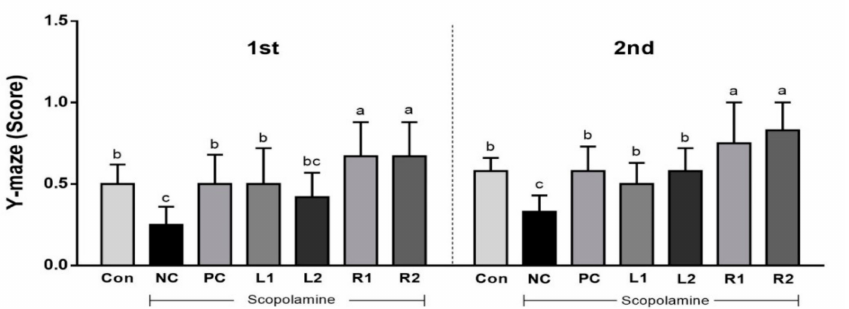
Figure 1. Effects of Allium hookeri leaf and root extracts on the Y-maze test score of C57BL/6 mice with memory impairment induced by scopolamine. All values are expressed as the mean ± SEM ( n = 7). a–c Differences were considered statistically significant at p <